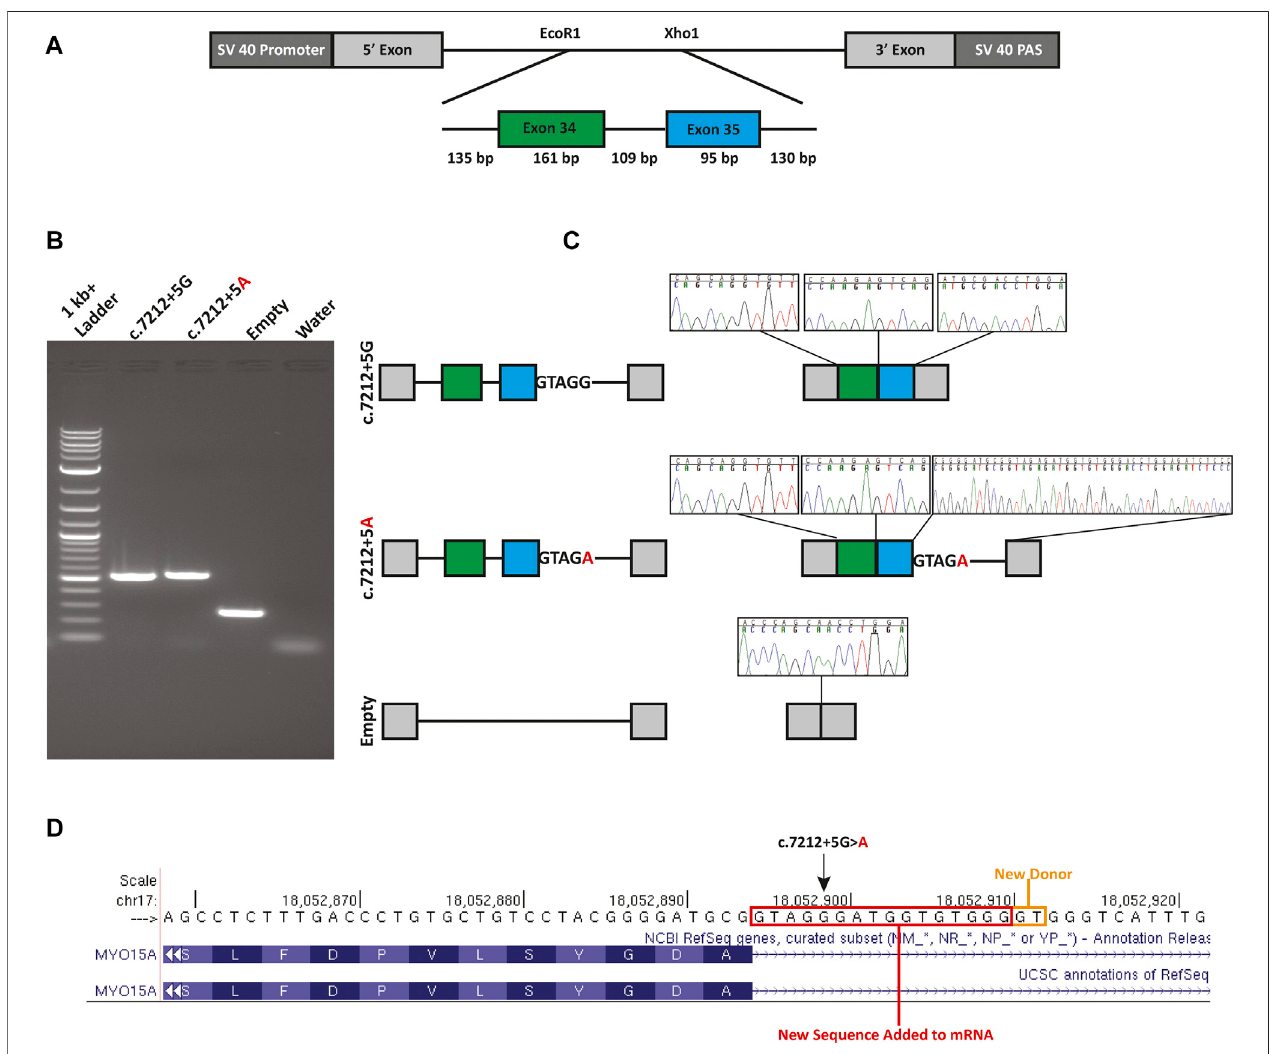
FIGURE 2 | Mini-gene splicing assay. (A) Mini-gene design. Exons 34 and 35, the 109 bp intervening sequence and fl anking intronic sequence of MYO15A were inserted into the EcoR1 and Xho1 site of the gene trap pSPL3 vector. (B) Gel electrophoresis of wildtype (c.7212+5G), mutant (c.7212+5A) and empty pSPL3 vector. The c.7212+5G > A variant causes the activation of a cryptic donor site. (C) Splicing schematic and chromatograms of sequenced spliced products. (D) Sequence chromatograms show the read through at each exon junction and sequence alignment shows the insertion due to the activation of a cryptic donor site. An orange box indicates the newly activated donor site and the red box highlights the retained intronic